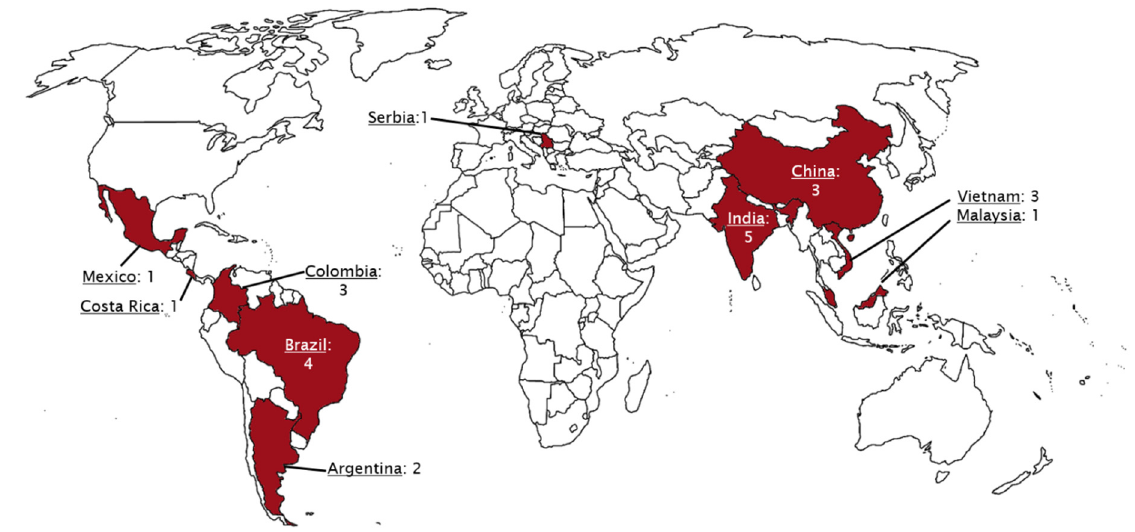
Figure 1. World map with countries highlighted. The numbers reflect the number of institutions reporting cases in the respective country. Cases spanned the globe with a slight predominance for countries in Asia. Note no cases were reported in Africa.